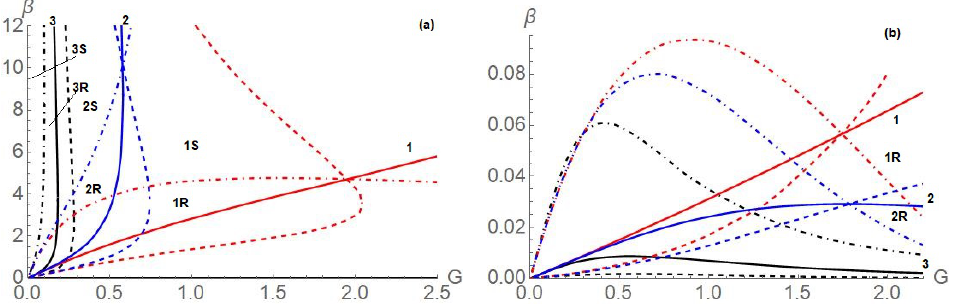
Figure 2. Pattern selection domains for the square lattice. The solid lines are for κ 1 = 0, the dashed lines are for κ 1 + κ 2 = 0, and dot-dashed lines are for κ 2 − κ 1 = 0. Here, the red-colored set (# 1 ) is for N = 0, the blue-colored set (# 2) is for N = 10 − 6 , and the black set (#3) is for N = 10 − 5 . The domains are marked: “R” for rolls, “S” for squares. Panel ( b ) is detailed panel ( a ) for small β